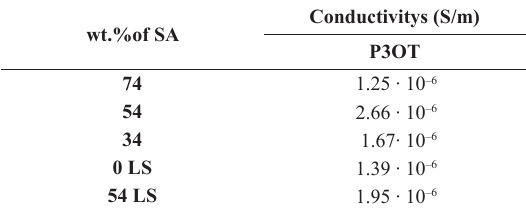
Table 3. Electrical conductivities for LB and LS films with diferent Stearic Acid Percentages. wt.%of SA